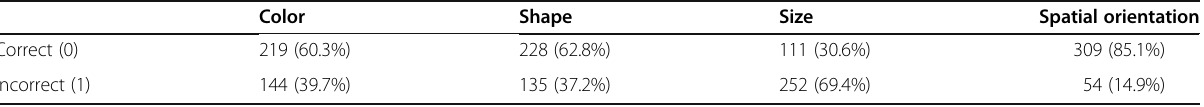
Table 4 Frequency table of color, shape, size, and spatial orientation in visualization